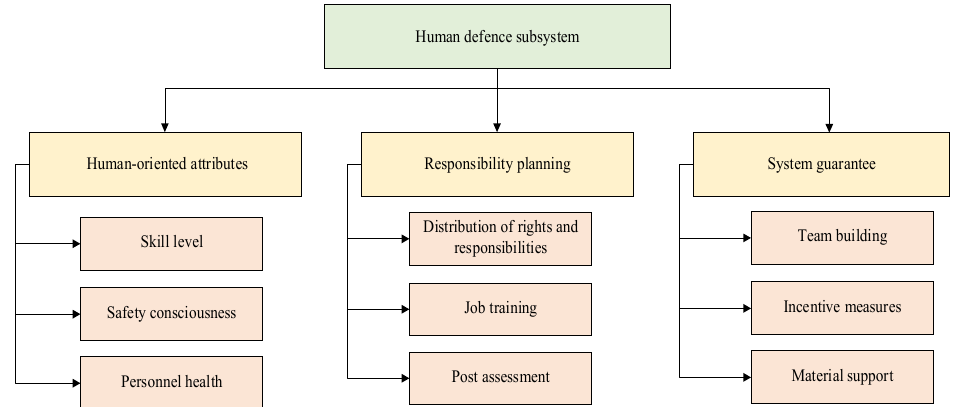
Figure 7. Measurement framework of the human defence system capability indicator.